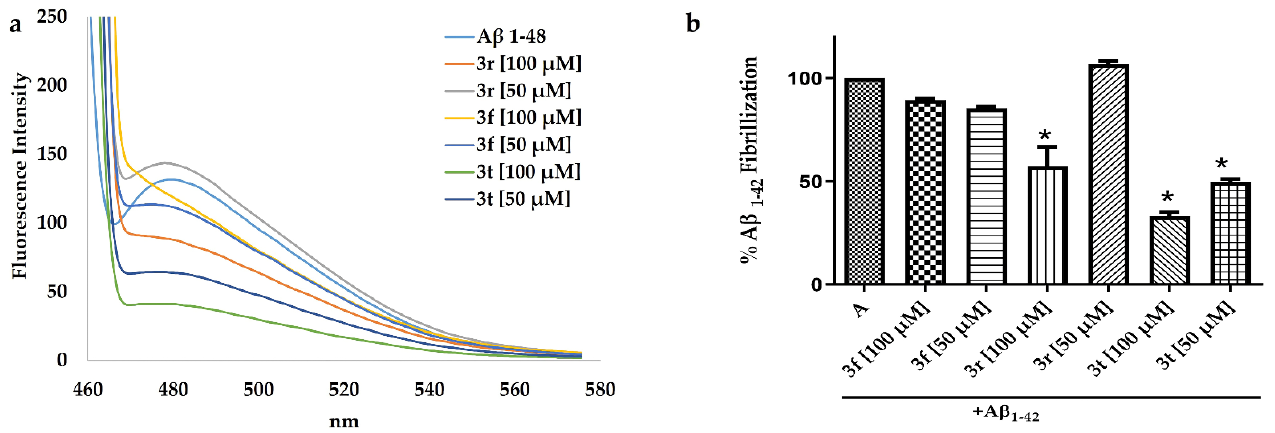
Figure 6. The anti- Aβ 1-42 aggregation of 3f, 3t and 3r compounds . ( a ) Fluorescence intensity spectra of ThT and Aβ 1-42 after 48 h of incubation at 37 °C. ( b ) Percentage of Aβ 1-42 fibrillization taking 100% of the Aβ 1-42 alone; the was percentage obtained after the incubation for 48 h with each compound. * Significant difference vs. Aβ 1-42 alone ( p < 0.05). * Significant difference vs. A β 1-42 alone ( p <